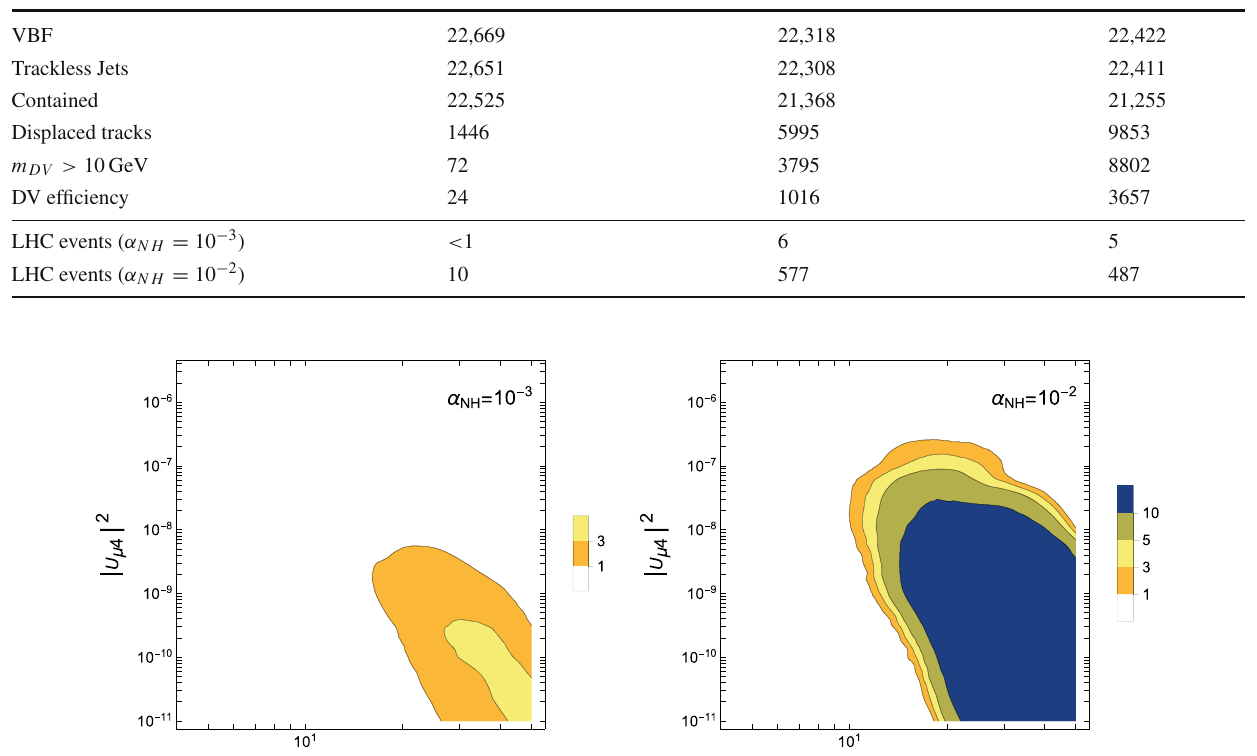
Fig. 5 Sensitivity of displaced jet search for the extended model at the LHC, for different choices of α